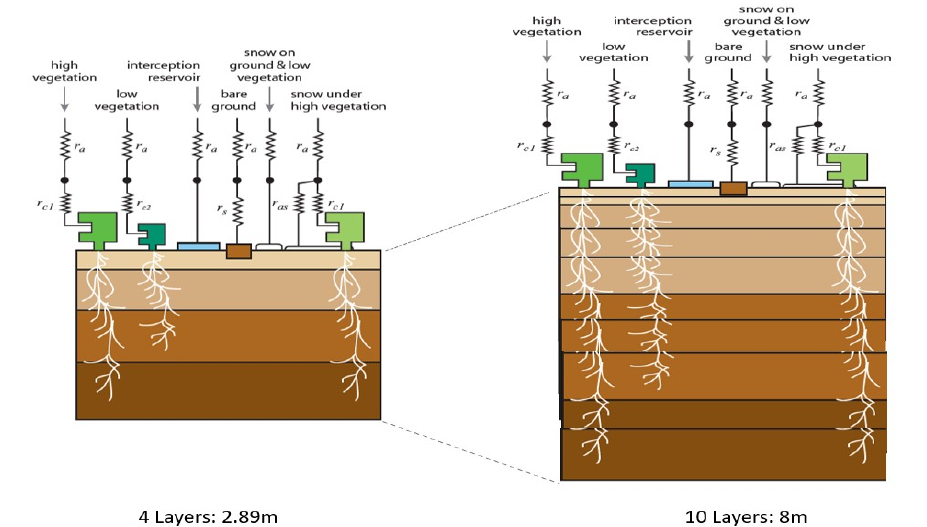
Figure 6. Updated soil depth and vertical discretization. ( Left ) current operational configuration with 2.89 m depth and 4 layers (7 cm, 21 cm, 72 cm, 189 cm). ( Right ) the updated configuration with 8 m depth and 10 layers (1 cm, 2 cm, 4 cm, 9 cm, 12 cm, 30 cm, 42 cm, 100 cm, 200 cm, 400